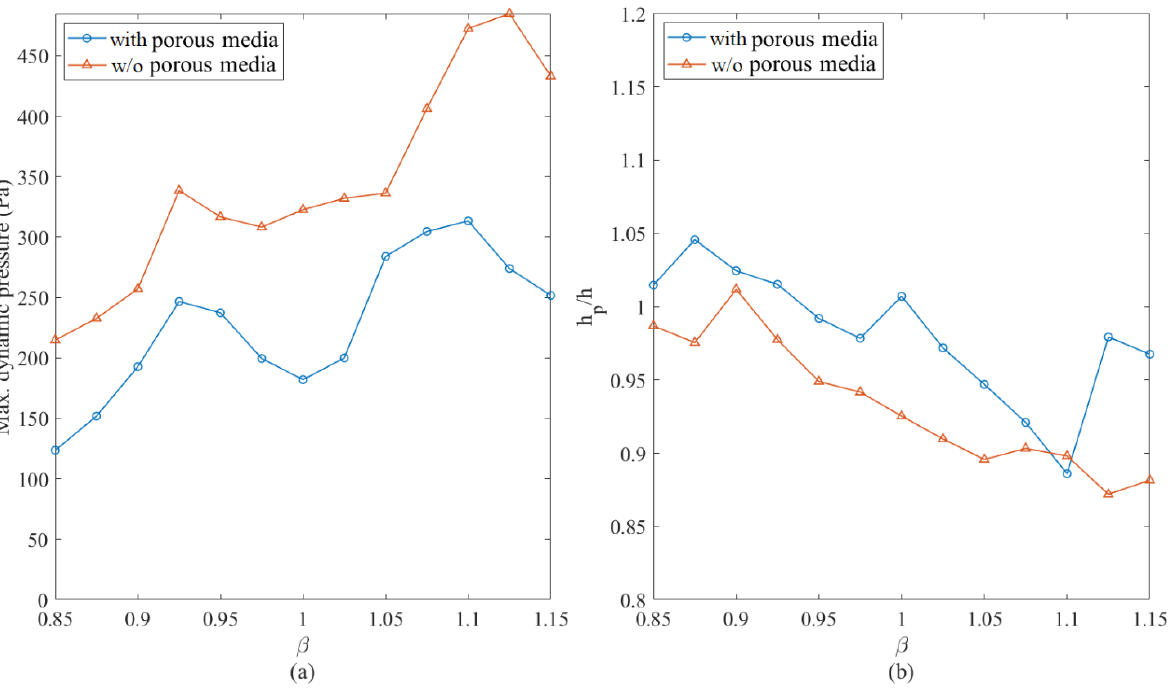
Figure 36. The frequency responses of the local sloshing behavior in the water tank on a floating body for the small-wave case: ( a ) maximum dynamic pressure on the wetted wall; ( b ) normalized height of pressure concentration.